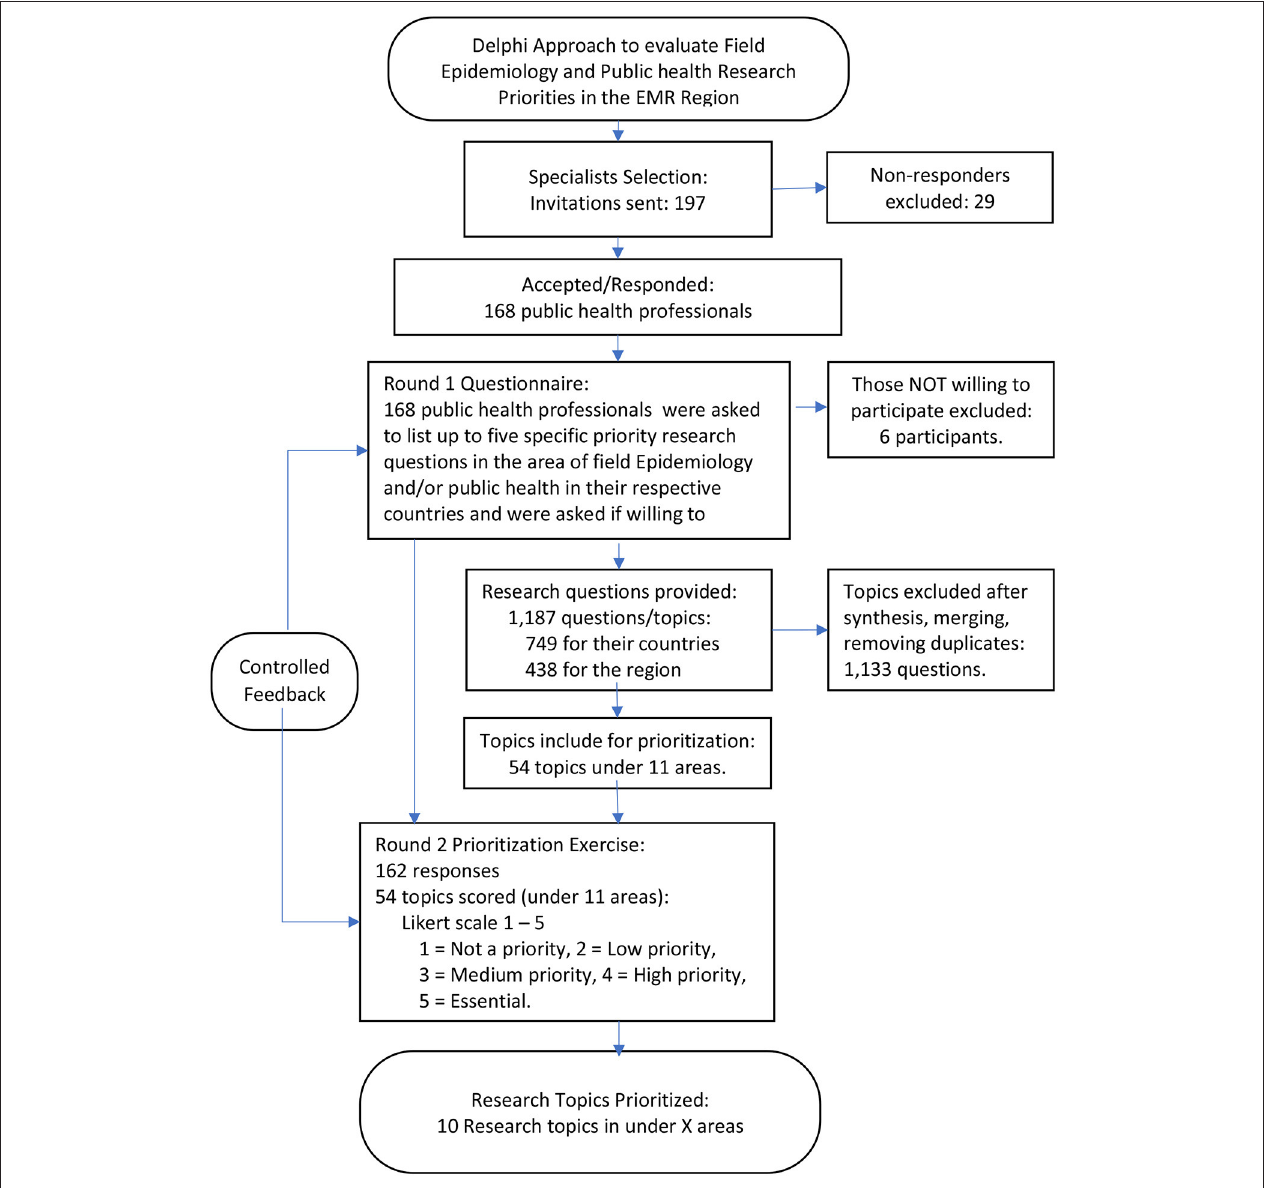
FIGURE 1 | The Delphi process to evaluate research priorities in the